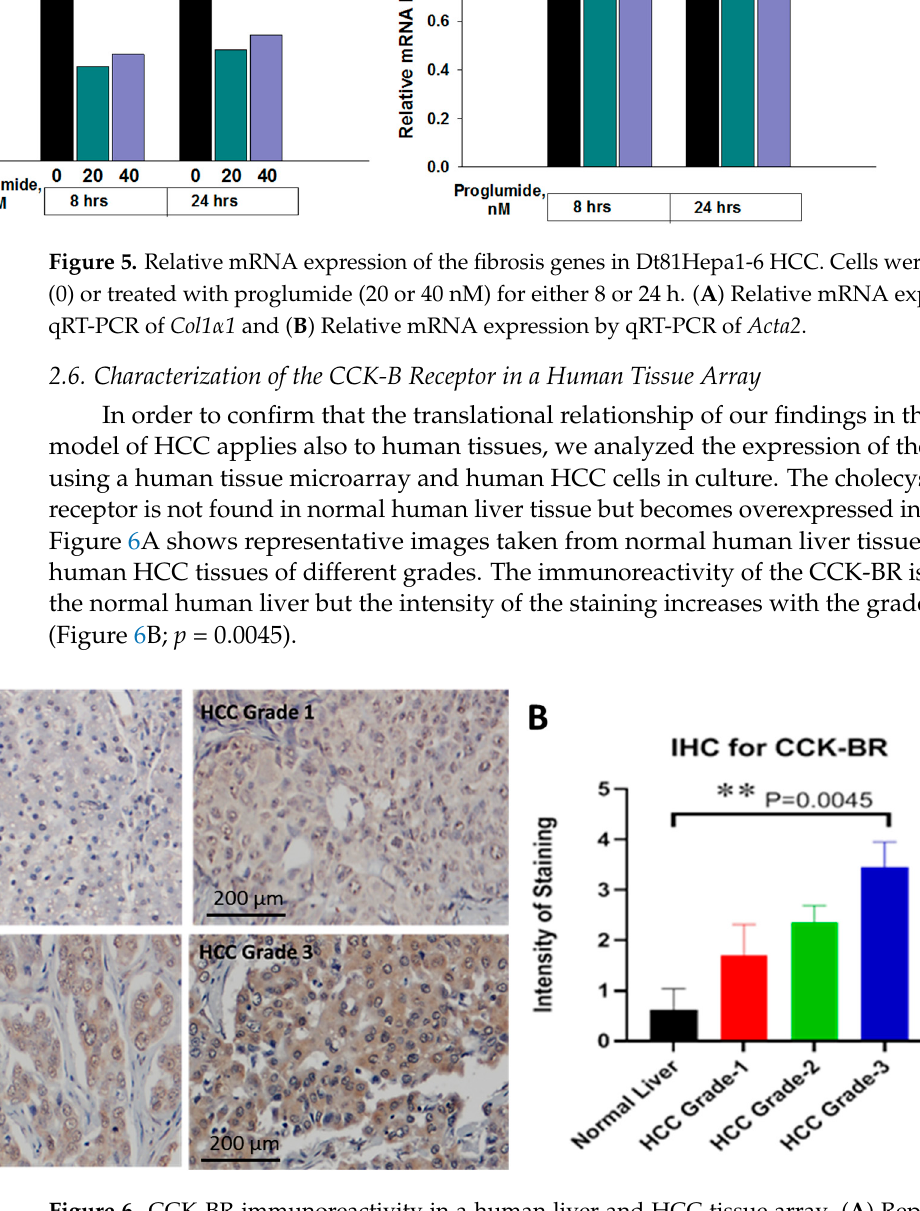
Figure 6. CCK-BR immunoreactivity in a human liver and HCC tissue array. ( A ) Representative photos from a human liver tissue microarray of normal liver and HCC tissues stained for immunore- activity for the CCK-BR. ( B ) Scoring of the human microarray show the absence of staining in normal human liver tissue and positive CCK-BR staining increases with the tumor